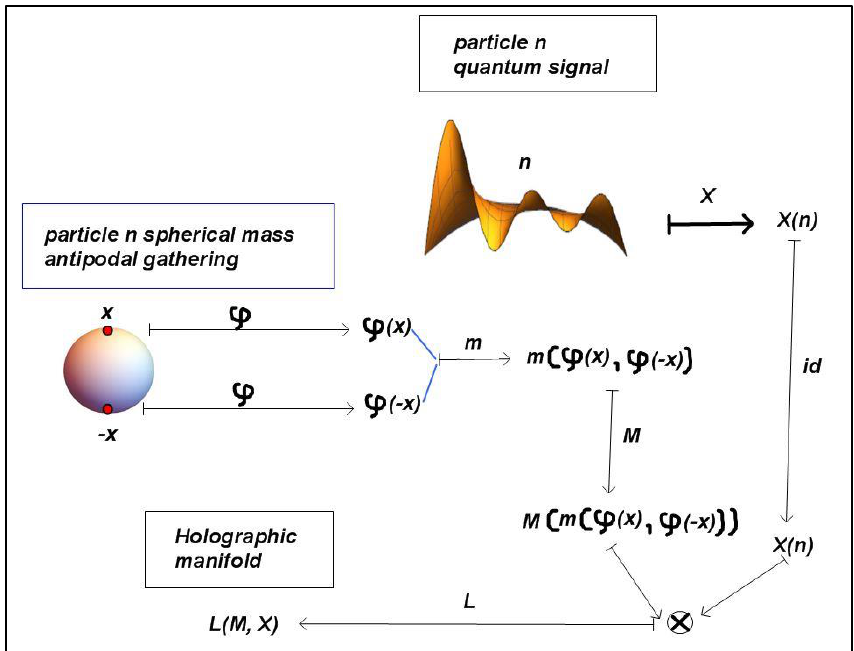
results from a synthesis of two signals: 𝑋(𝑛) and 𝑀(𝑚(𝜑(𝑋(𝑛)), 𝜑(−𝑋(𝑛)))) .